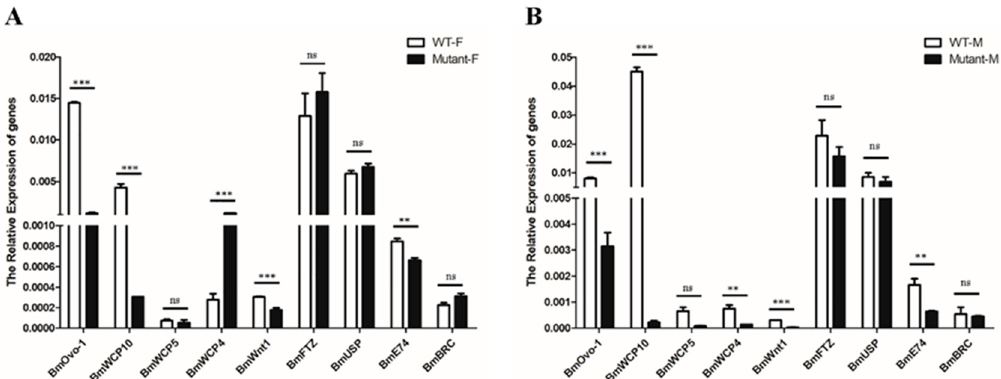
Figure 4. Genes involved in wing development are downregulated in the BmOvo mutants. ( A ) Levels of indicated mRNAs in female adult BmOvo mutants relative to wild-type levels. ( B ) Levels of indicated mRNAs in male adult BmOvo mutants relative to wild-type levels. Three individual biological replicates of real-time PCR were performed. The asterisks indicate significant differences (** p < 0.01 and *** p < 0.001) compared with the wild type in the adult stage determined using a two-tailed t -test.